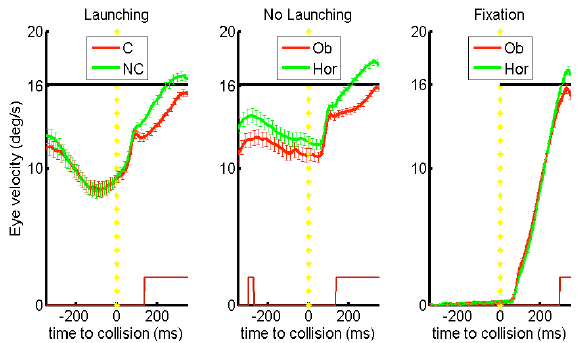
Figure 3. Smooth pursuit average velocities over time per condition. Graphs show vectorial eye velocity per condi- tion (Launching/No-Launching/Fixation) and target se- lection. Red lines indicate that the first saccade after col- lision was closer to the causal/oblique target. Light green lines indicate saccades to the non-causal/horizontal tar-